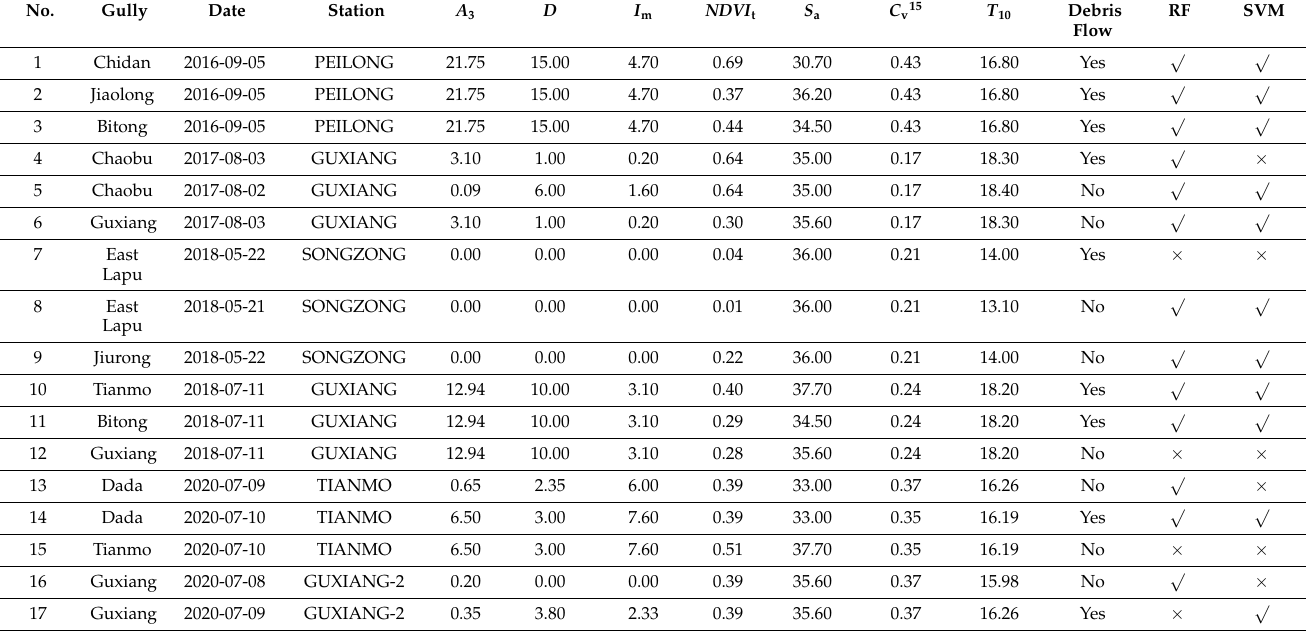
Table 12. Prediction results of different models on the 17 events of the testing set.